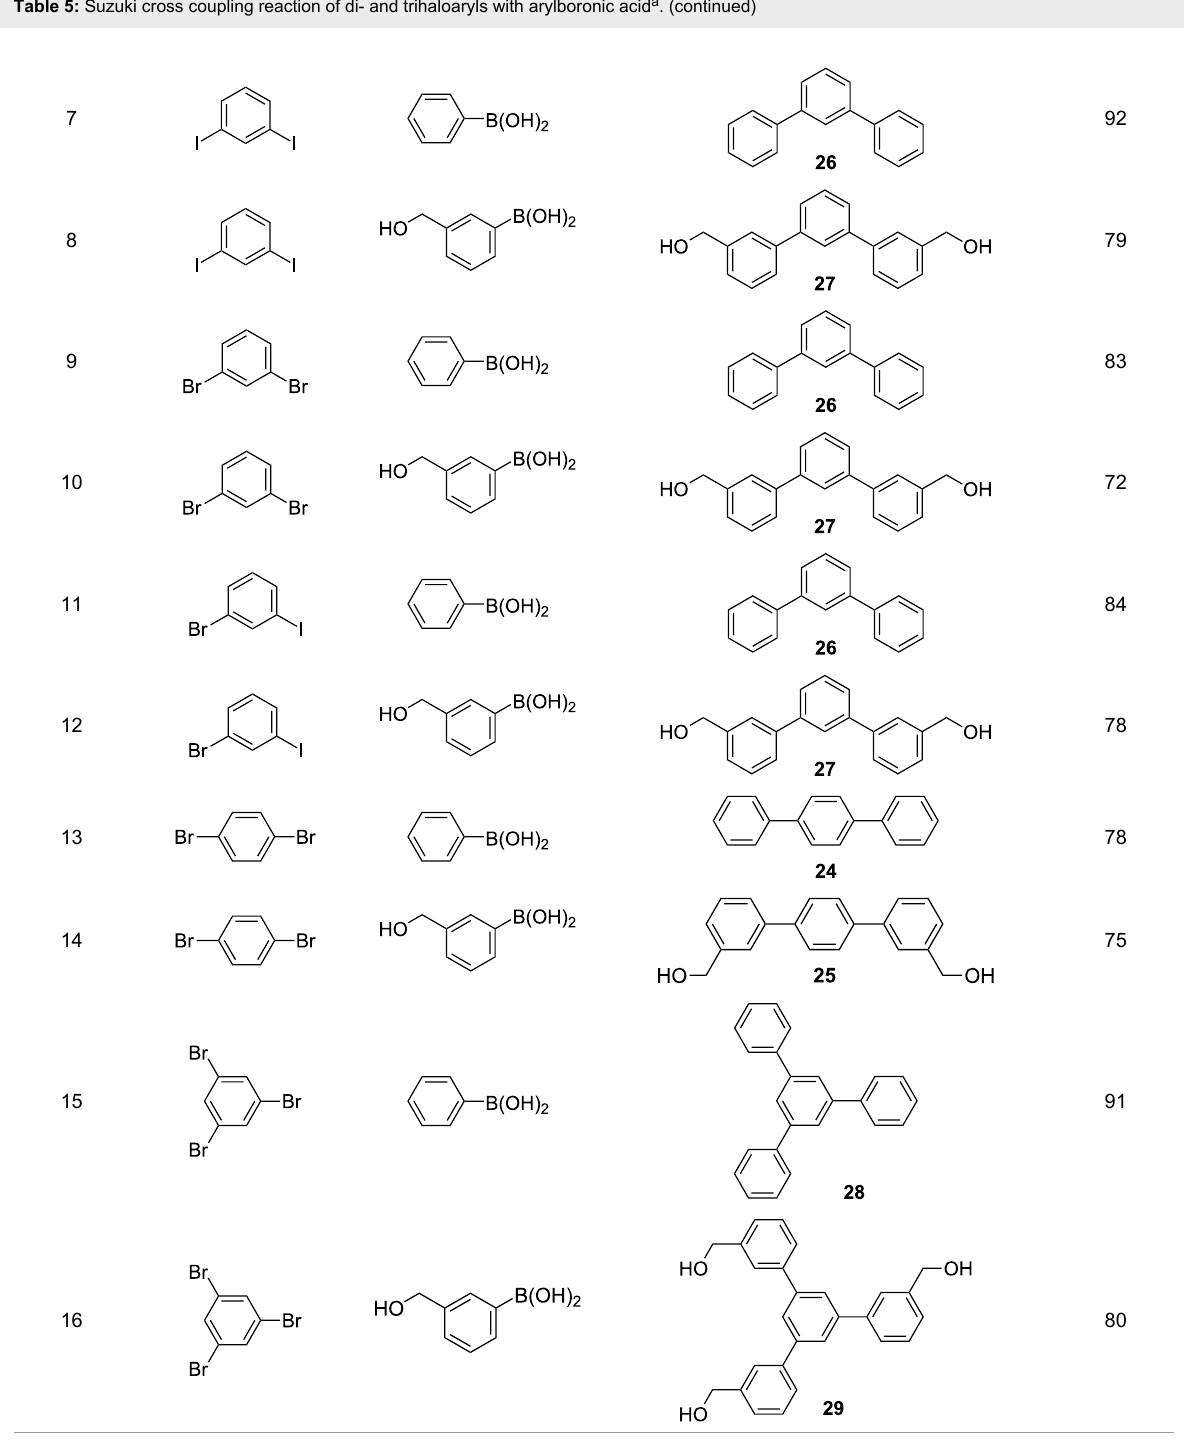
Table 5: Suzuki cross coupling reaction of di- and trihaloaryls with arylboronic acid a .